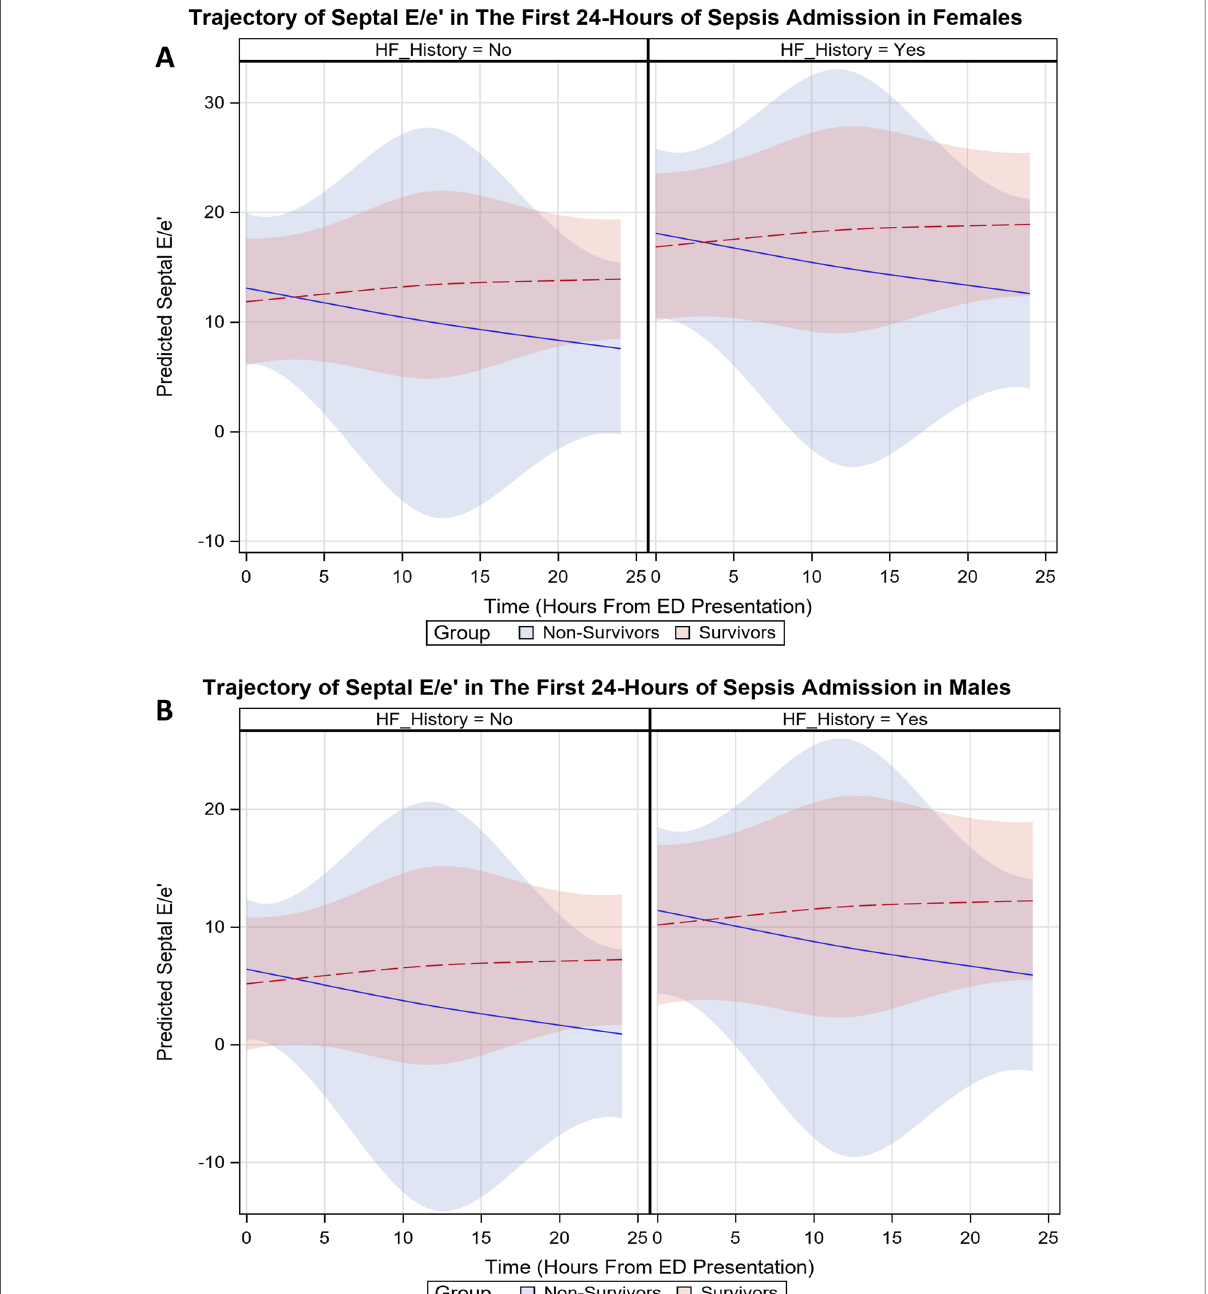
Fig. 1 Trajectory of model-predicted septal E/e ′ during the first 24 h of admission. Time–death interaction plot showing a different trajectory of predicted septal E/e ′ in survivors versus non-survivors, adjusted for age, biologic sex, ED SOFA score, ED Troponin-I, IV volume given in 24 h, and baseline IVC collapsibility, stratified by heart failure history; bands represent 95% CIs. A depicts the relationship in females; B depicts the relationship in